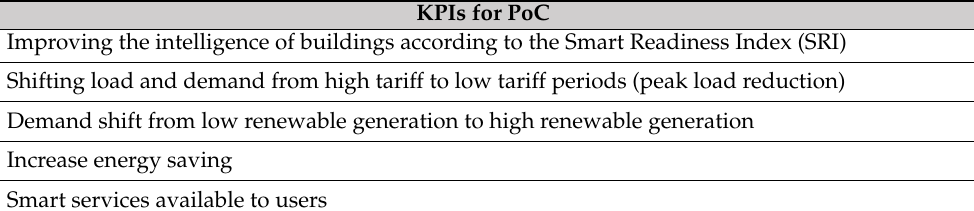
Table 2. PoC’s KPIs.